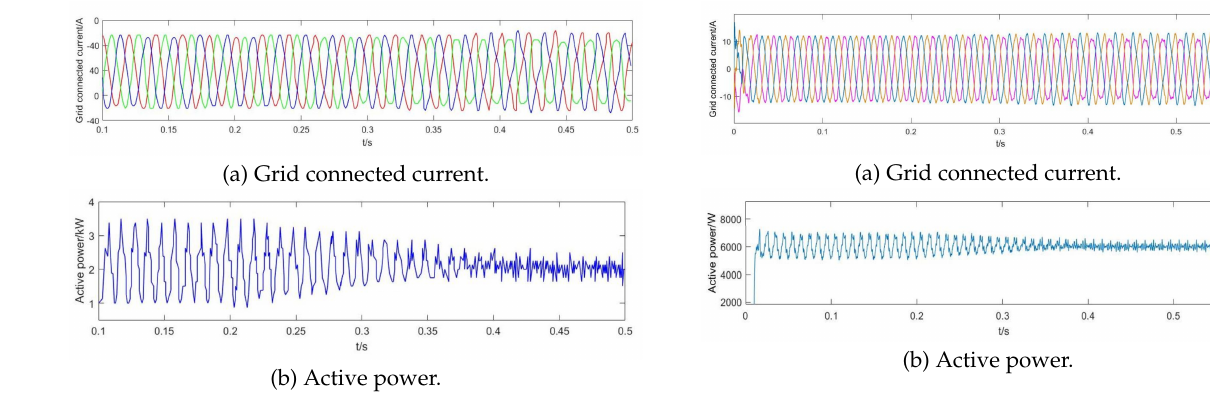
Fig. 9. Simulation results of coordinated control scheme in reference [7].